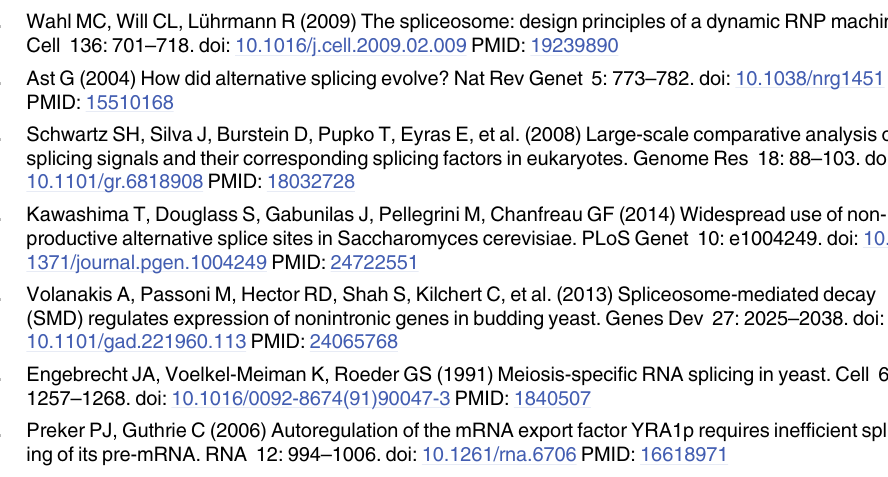
S5 Fig. Diagrams for each class of novel introns and alternative splicing described in the text. Alternative transcript models together with their idealized read coverage in next genera- tion sequencing data. The black line represents the total read coverage of all mapped reads. The green, red and blue lines represent characteristic reads for certain isoforms. (A) Split reads defining an intron. Reads r1 through r4 are mapped to the genome in a spliced form; the poten- tial intron is supported by 4 reads. Reads r1 and r2 represent the same fragment, because they have exactly the same sequence and hence the same start and end position on the genome. As a result, the potential intron is supported by three distinct fragments. (B) Intron retention. The total read coverage (black) drops in the area of the intron and the intronic area is spanned by split reads (green). Ungapped (red) reads containing the 3 ’ or 5 ’ splice site are evidence of intron retention. (C) Alternative 3 ’ splice site. The total read coverage is lower in the intron, but shows an increase towards the 3 ’ site. There are two different types of overlapping split reads (green and blue), using the same 5 ’ splice site, but different 3 ’ splice sites. (D) Alternative 5 ’ splice site. Similar to alternative 3 ’ splice sites, but mirrored. (E) 5 ’ UTR intron. The intron is located before the start codon and the coding sequence (yellow) starts downstream. (F) Novel terminal intron. The intron overlaps the annotated stop codon and splices it out, extending the coding sequence to the next downstream stop